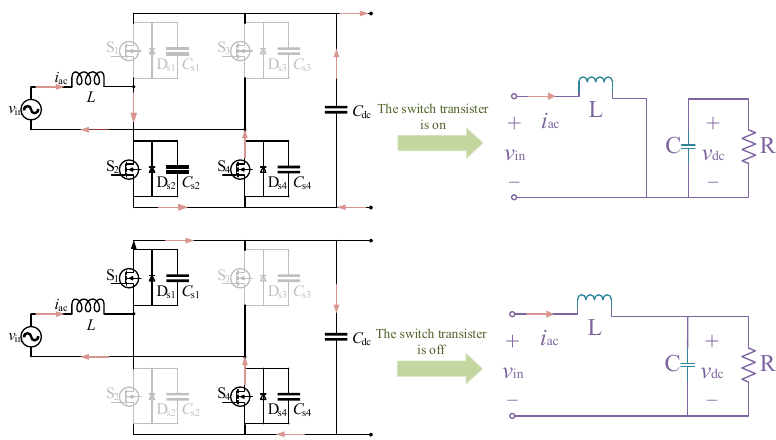
Figure 3. Forward equivalent circuit of bidirectional totem pole.